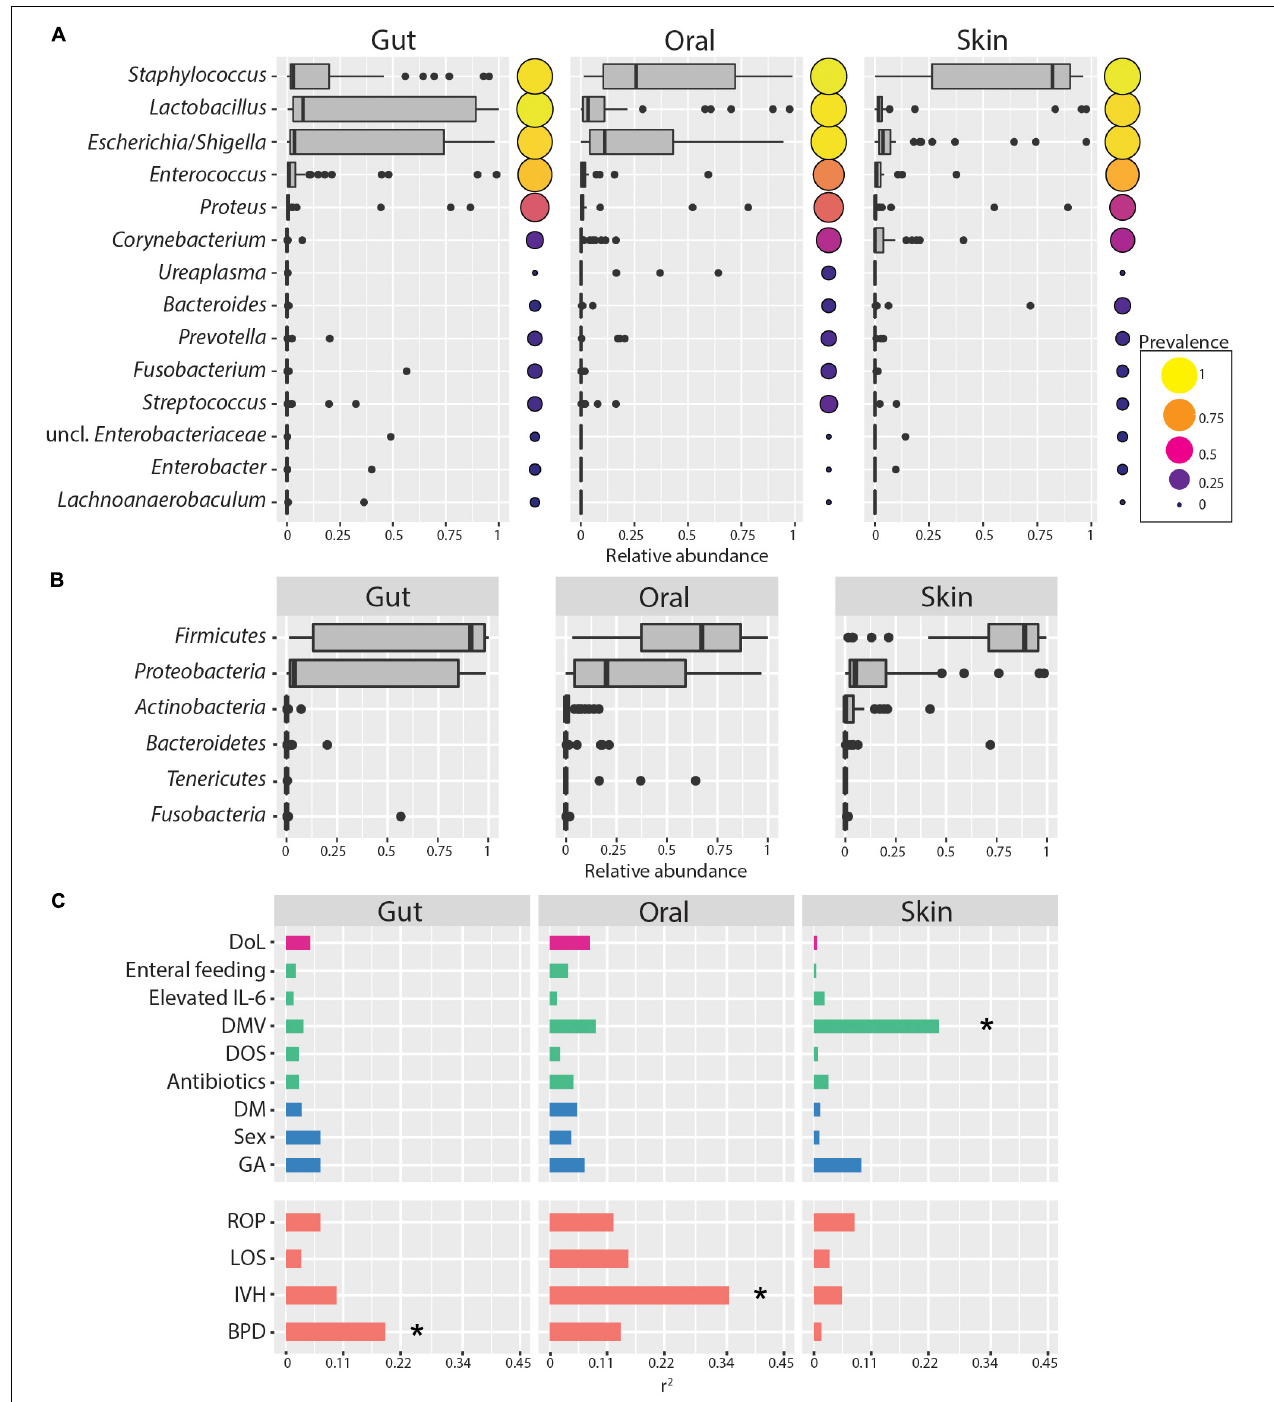
FIGURE 1 | Skin, oral cavity, and gut microbiome composition of ELBWI. (A) Relative abundances of bacterial genera across body sites. Genera with > 0.2 relative abundance in at least one sample are shown. Circle size and color indicates genus prevalence in the dataset. (B) Relative abundances of phyla across body sites. (C) Association of microbiome composition with clinical parameters and disease outcome (using the envfit function. Pearson correlation coefficient [r 2 ] on X -axis). DoL, days of life; elevated IL-6 = IL-6 > 150 pg/ml in the time window of 2 days before to 2 days after sampling; DOS, number of days with at least 12 h per day of FiO 2 > 21% up to the day of sampling; DMV, days with mechanical ventilation support till the day of sampling. Antibiotics = cumulative index for days of antibiotic administration accounting for different compounds per day; GA, gestational age; DM, delivery mode; ROP, retinopathy of prematurity; IVH, intraventricular hemorrhage; BPD, bronchopulmonary dysplasia. * p -value < 0.01.